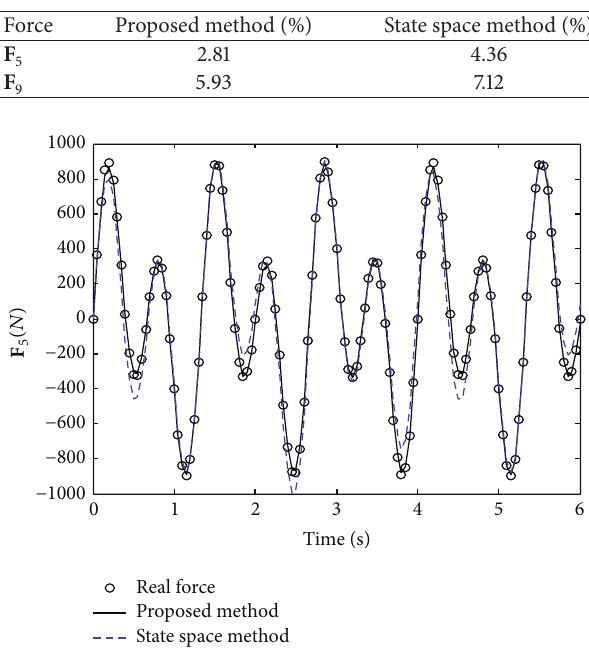
Table 2: Relative errors of force identification.